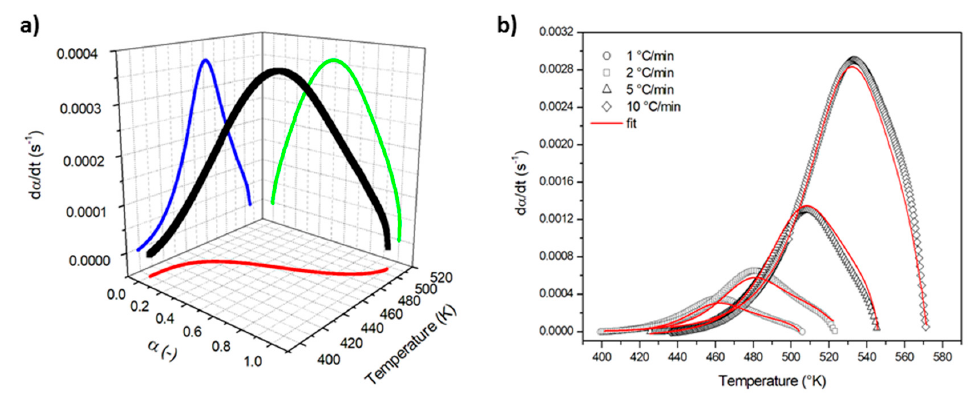
Table 2. Kinetic parameters for the PRISM EP 2400 resin.